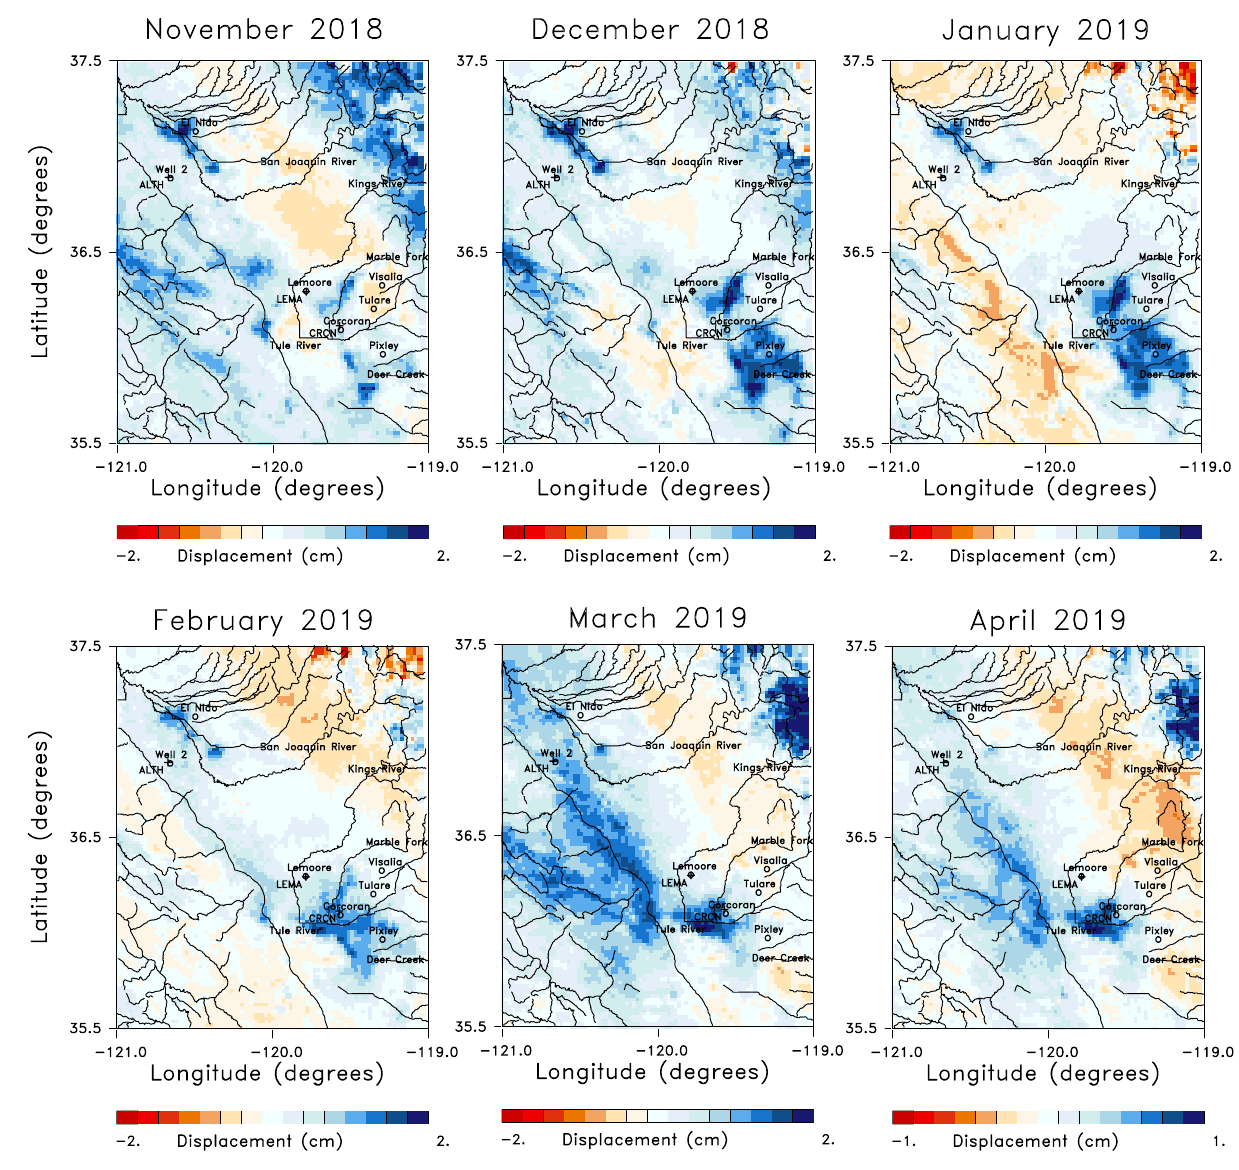
Figure 4. Six monthly line-of-sight displacements from the years 2018 and 2019. Rivers and streams in the region are indicated by the solid lines while several towns in the area are denoted by open circles and labeled. The locations of the GPS stations ALTH, LEMA, and CRCN are also shown as +’s in this panel. The location of a monitoring well discussed in this paper, water well 2, is denoted by an open circle. The colors represent the line-of-sight displacements obtained after removing the long term quadratic trend from each displacement time series. The plots were constructed using NCL and NCAR Graphics 6.5.0 (https:// www. earth syste mgrid. org/ datas et/ ncl. 650.